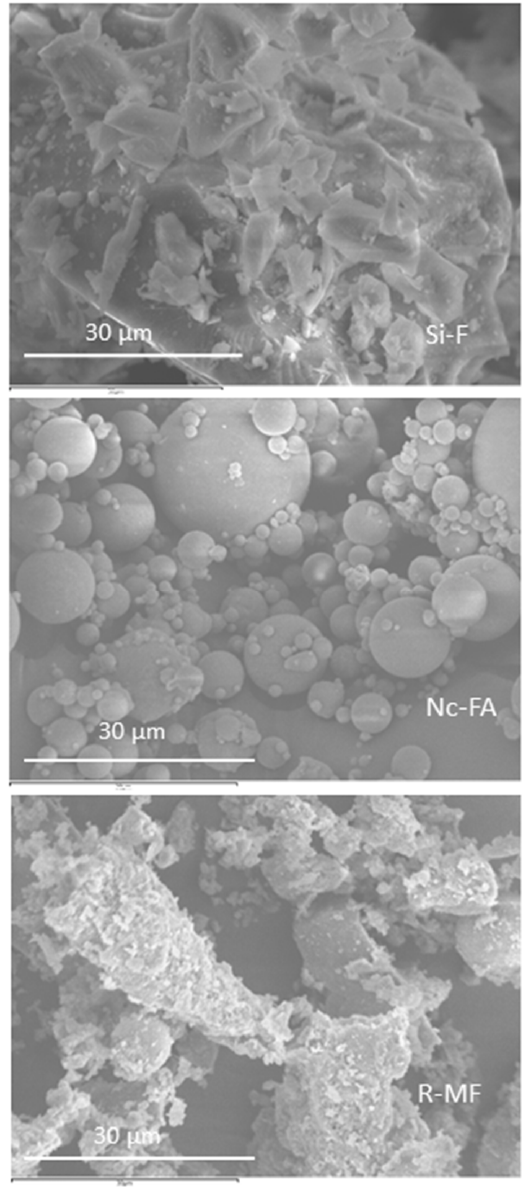
Figure 5. SEM images of Si-F, Nc-FA and R-MF. Table 5. Characteristics of CEM I/52.5R.